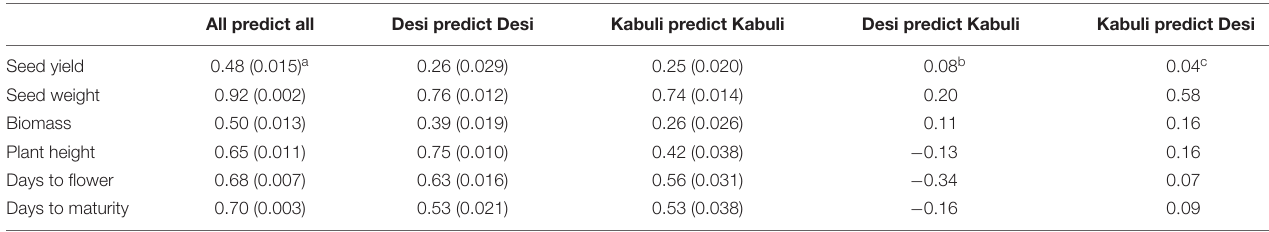
FIGURE 2 | Plots of the first two principal components of the additive genomic relationship matrix for maize and chickpea populations. TABLE 1 | Genomic prediction accuracies for chickpea GEBVs across environments with various training and test sets estimated using 10-fold cross-validation. All predict all Desi predict Desi Kabuli predict Kabuli Desi predict Kabuli Kabuli predict